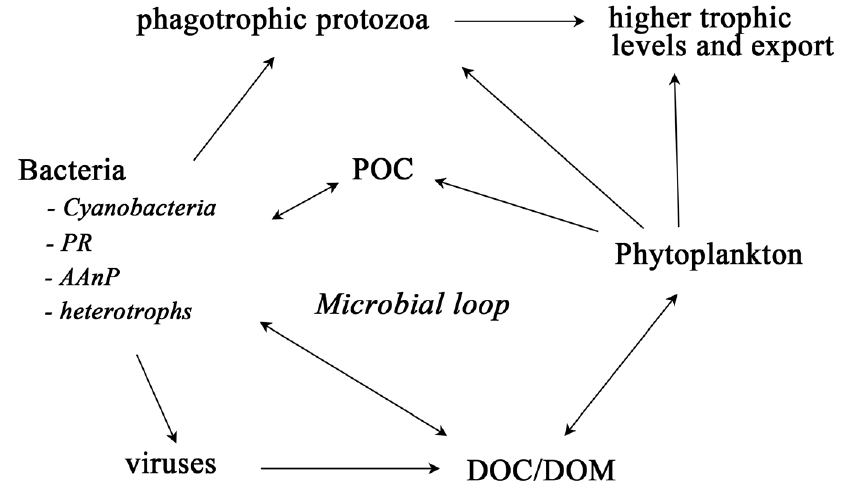
Figure 2. Sea ice food web and the microbial loop. The microbial loop re-drawn and abridged from Azam et al. (1983) and Fenchel (2008). Only the bacteria discussed in this review are presented; the other bacteria are grouped as heterotrophs. AAnP = aerobic anaerobic phototroph, DOC = dissolved organic carbon, DOM = dissolved organic matter, POC = particulate organic carbon, PR =